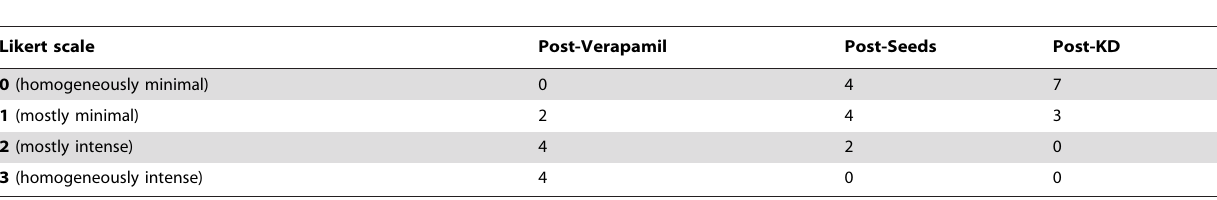
Table 1. Image assessment of myocardial uptake of 18 F-FDG.